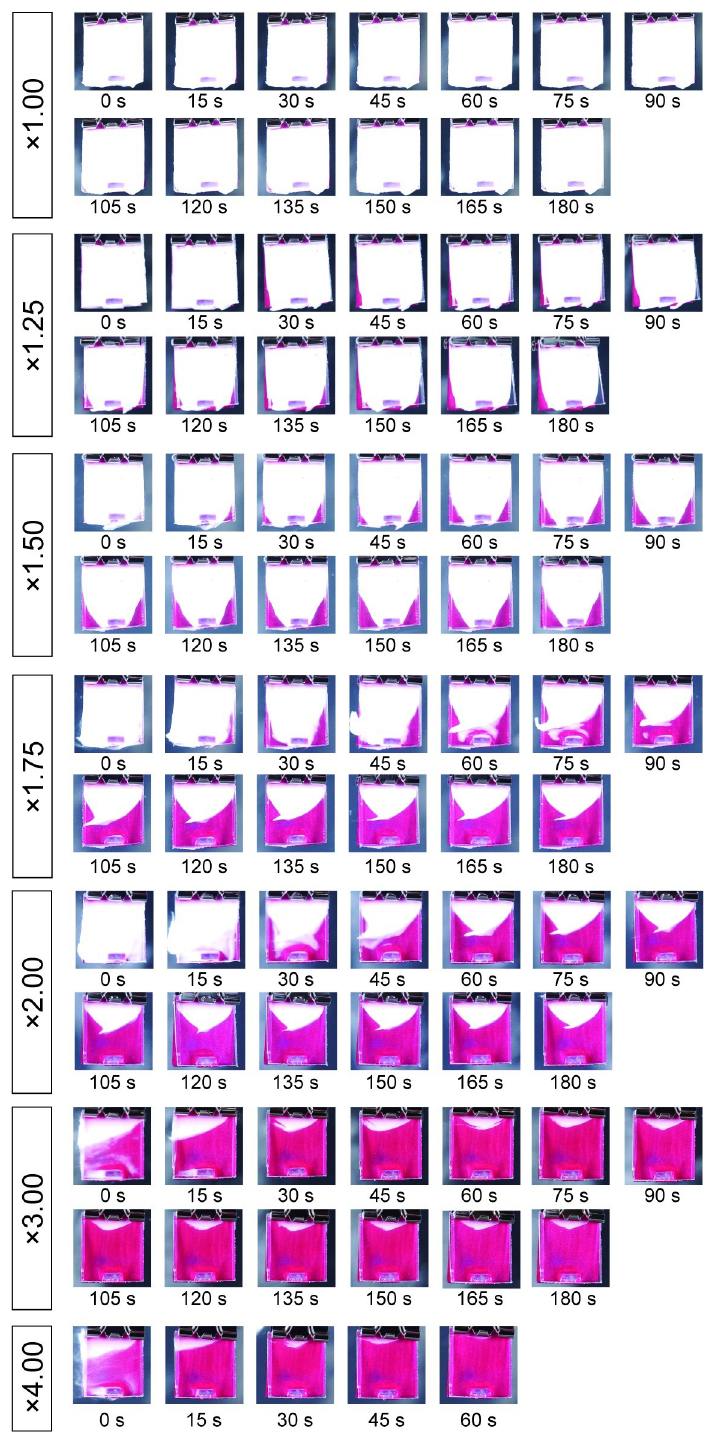
Fig 2. Flow comparison for each dentifrice dilution rate by interdental model. The time of exposure to water flow and the remaining area of the dentifrice in the interdental model are shown. This model reproduced the interdental part by forming a gap between the two acrylic plates. The white part indicates the dentifrice filled in the gap, and the red part indicates that the dentifrice has been washed out. Images are shown every 15 s for up to 180 s.